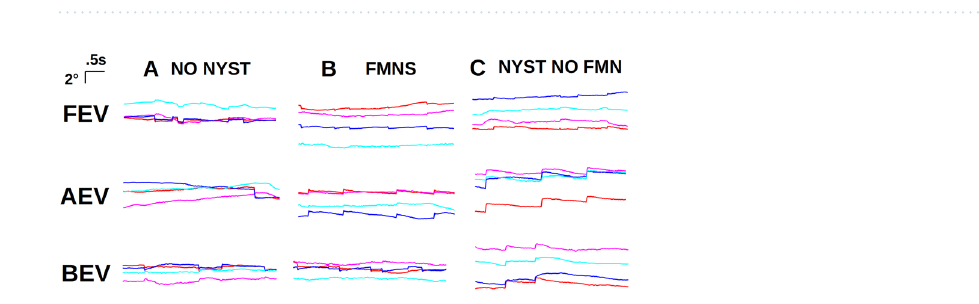
Figure 1. Eye movement records. Eye positions vs time for patients without nystagmus ( A ), FMNS ( B ), and with nystagmus but not FMNS ( C ), during fellow eye viewing (top row), amblyopic eye viewing (middle row), and both eyes viewing (bottom row). Waveforms are plotted with a common scale indicated at upper left. Red: right horizontal, blue: left horizontal, magenta: right vertical, cyan: left vertical. The positive vertical axis corresponds to rightward and upward eye movements. Note the reversal in direction between FEV and AEV in FMNS patients that is not present in nystagmus without FMN patient. Note also the greater intensity during AEV and the absence of acceleration during slow phases in nystagmus patients both with and without